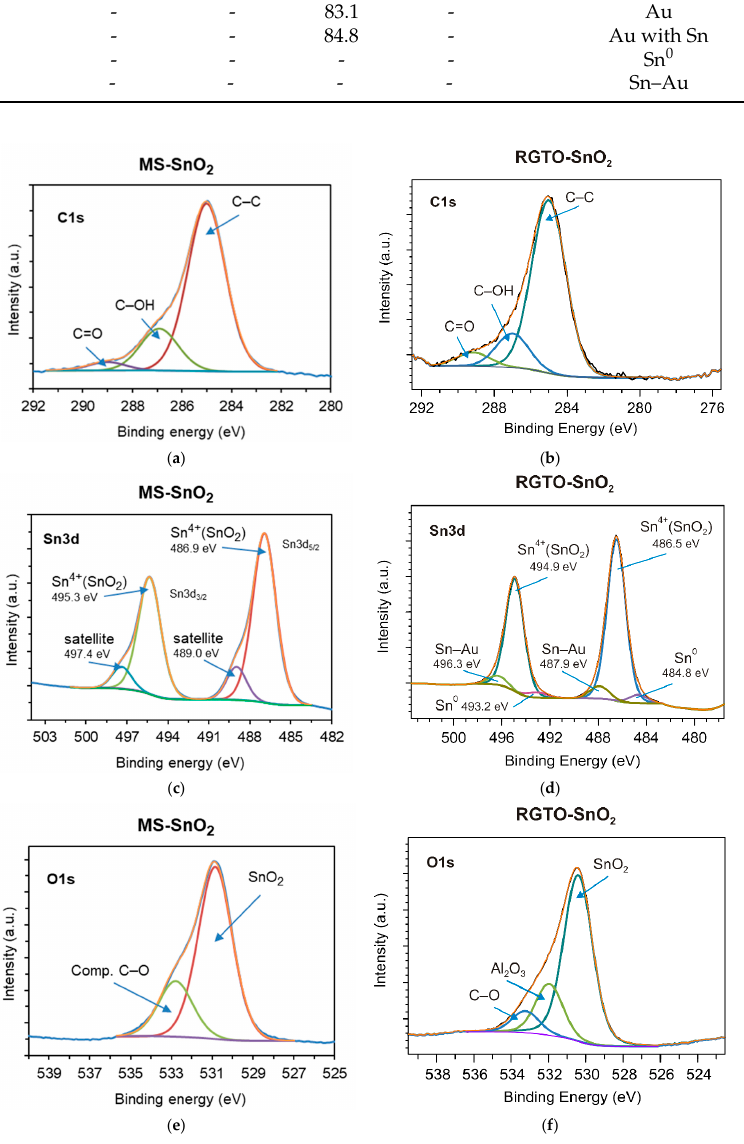
Figure 10. Deconvoluted ( a , b ) C 1s, ( c , d ) Sn 3d, and ( e , f ) O 1s core-level XPS spectra of MS-SnO 2 (thickness = 300 nm) and RGTO-SnO 2 films, as indicated.